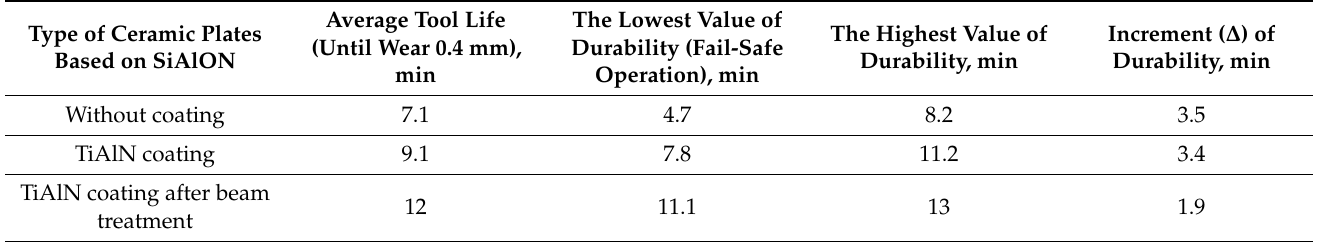
Table 2. Dispersion in durability values (stability) of ceramic plates experimentally established during operational